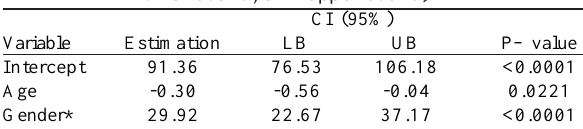
Table 5. Linear regression model of MEP containing only the covariates of age and gender (CI=confidence interval;